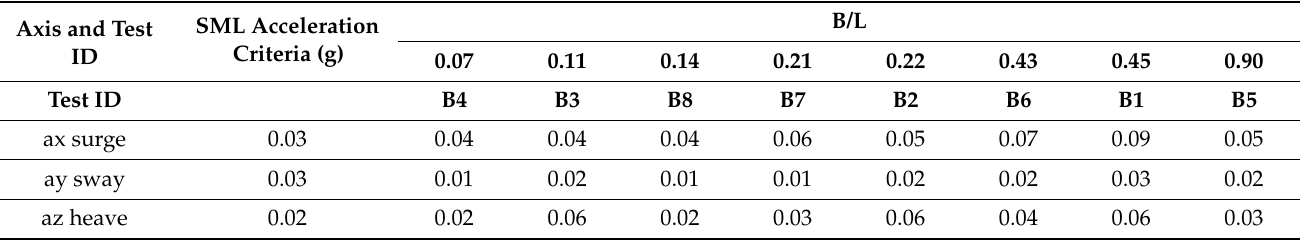
Table 6. Root Mean Square (RMS) Acceleration in x-, y-. and z-axis for each of the tested wave periods for Narrow and Wide Pontoons. All values given in g. Bold indicates exceedance of